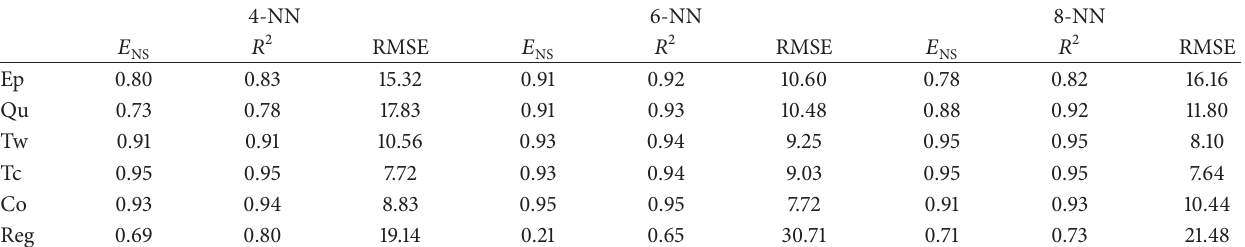
Table 5: Details of simulation results with six different precipitation infilling methods in Imha